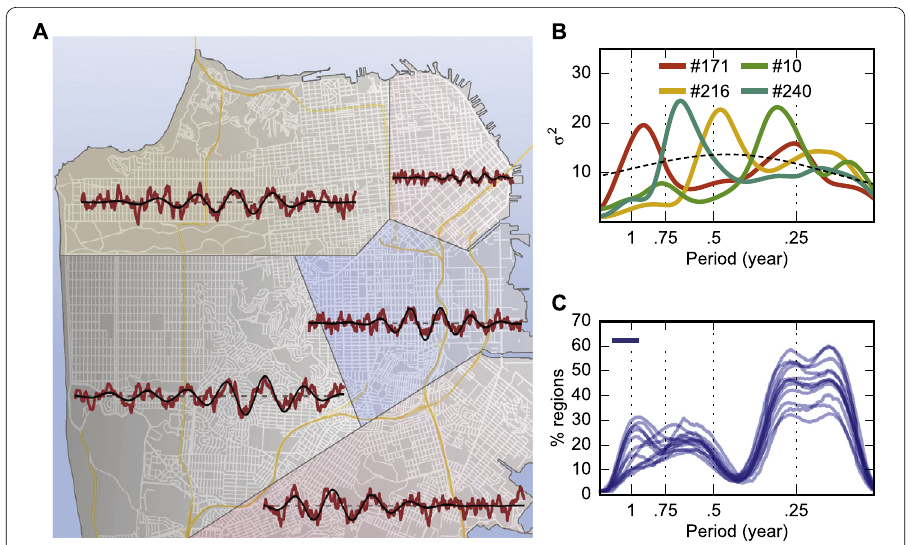
Figure 2 Crime exhibits temporal regularities that are hidden in city-level aggregated data. To analyse the heterogeneity in cities, we divided each city into regions of same population size and created the time series Y c i of each region. A pictorial example of San Francisco is shown in ( A ). With the global wavelet spectrum of the wavelet transform of Y c i , we found that regions in the city might have other rhythms of crime, unseen in the aggregated data. For example, ( B ) depicts the global wavelet spectrum of selected regions (solid curves) in San Francisco and the null model (dashed curve). To describe these periods in the whole city, we developed the composed spectra C c ( s ) that gives us the proportion of regions that exhibit a period s . Each curve in ( C ) represents C c ( s ) of each considered city c in our analysis, showing the signature of criminal periodicity in